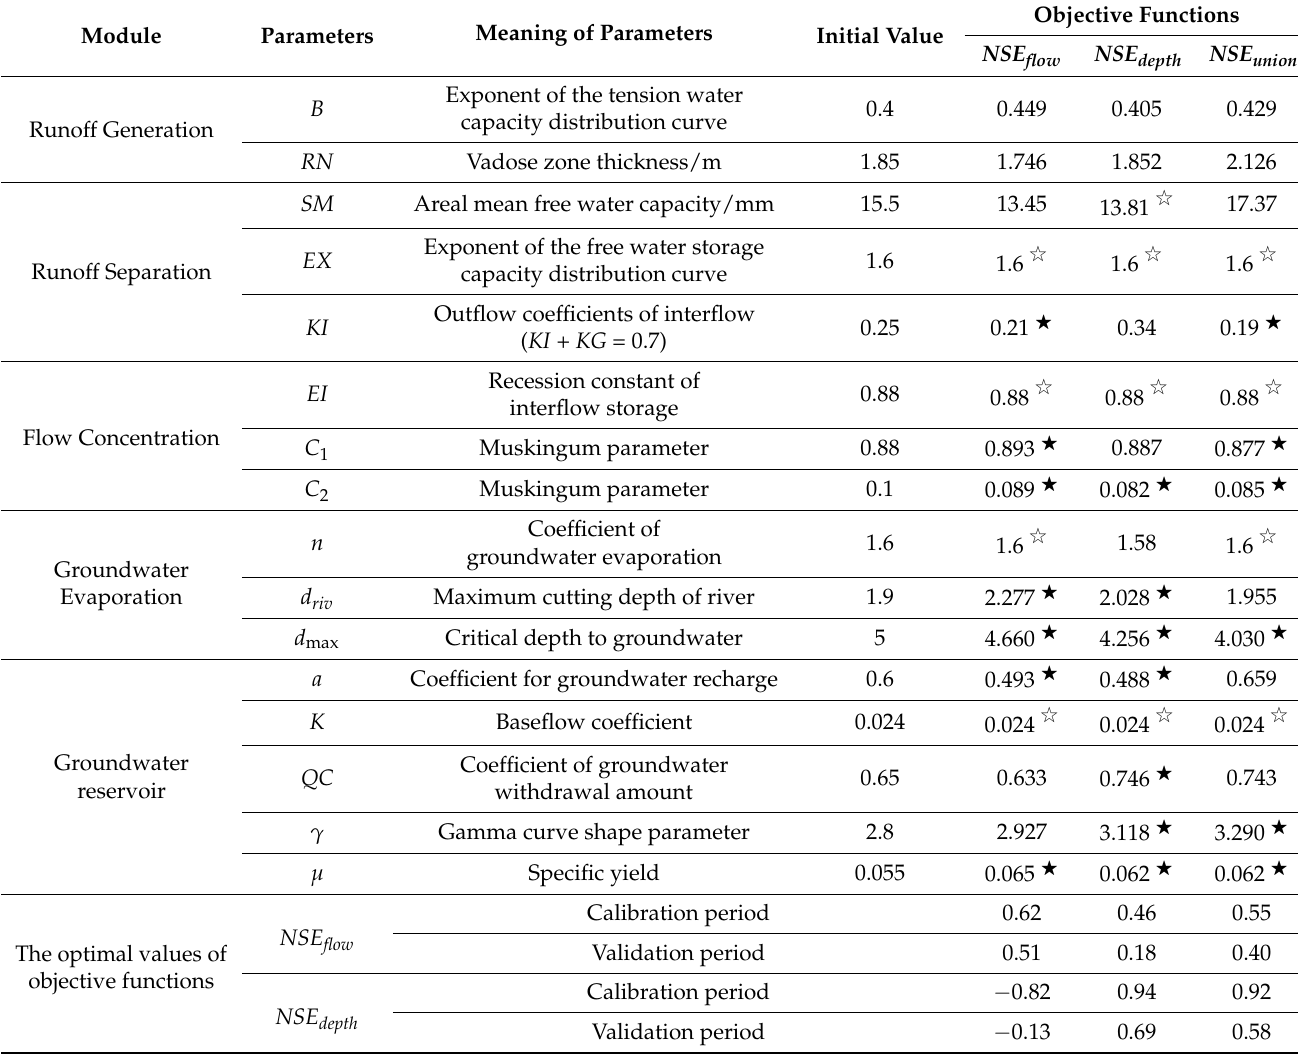
Table 2). By normalizing the likelihood function, the sensitive and insensitive parameters are identified according to the single-objective functions NSE flow and NSE depth , as well as the multi-objective function NSE union . The sensitive parameters are calibrated against the observed streamflow and groundwater depth from 2001 to 2004 using the SCE-UA algorithm. The model is validated for the period from 2005 to 2009. The optimal parameter settings are listed in Table 2, and the simulation results are shown in Figures 3–5. Table 2. The model parameters and calibration